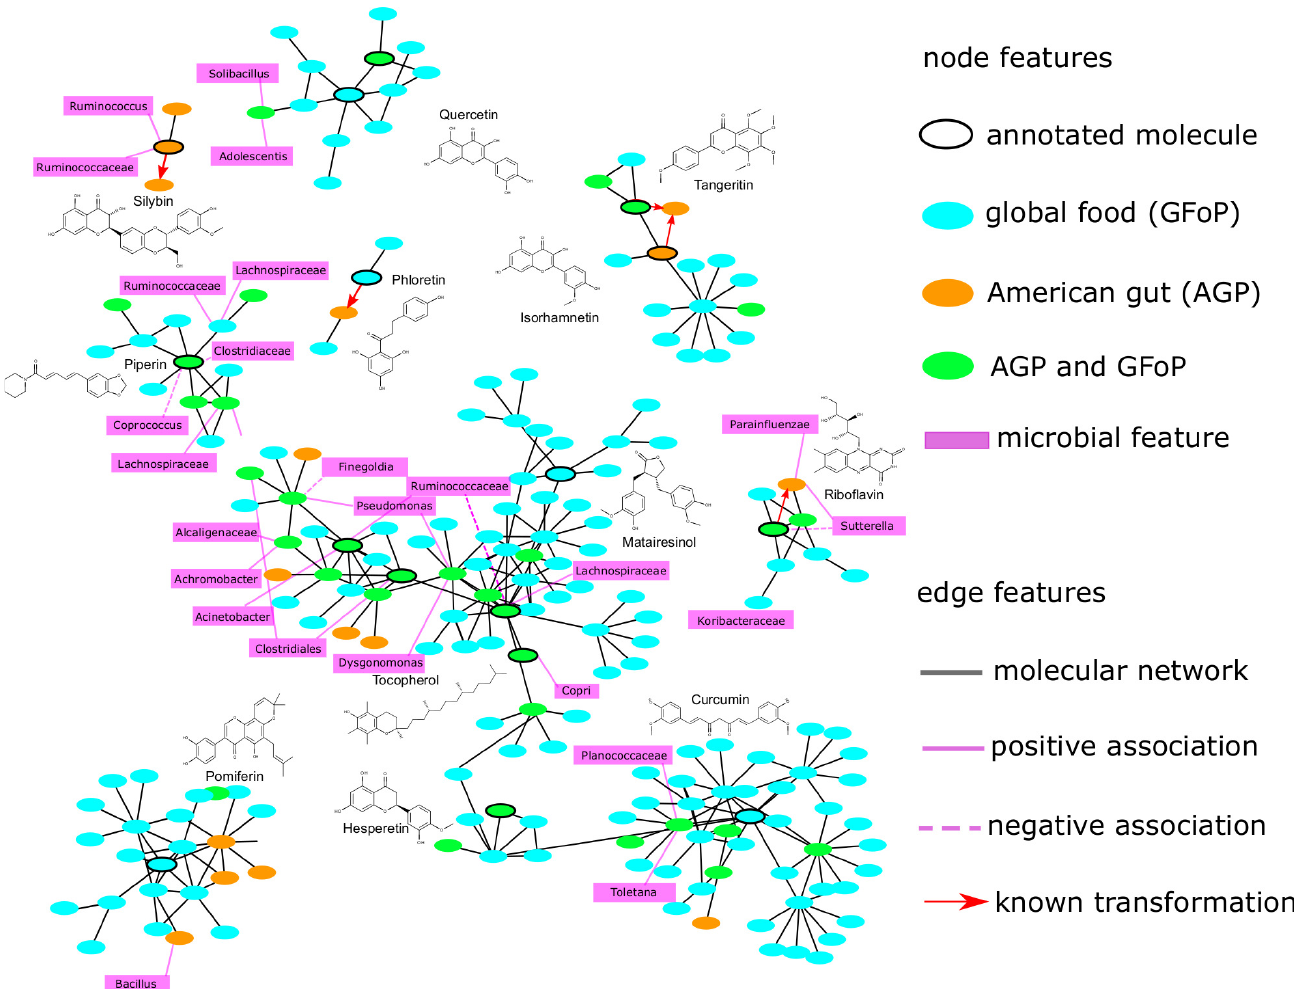
Figure 2. Integrating molecular and association networks. As the size of the network is enormous (41,765 nodes and 45,479 edges), here, we focus on some of the networking families that have a known molecule identified by Dereplicator+ [34] as a polyphenol or a vitamin (25 molecules in total). The network for all 25 molecules is shown in Figure S5. As the association network is currently too dense to visualize, we only show the top two microbial features for each molecular feature (Fisher p - value of 10 − 5 ). The known transformations were reported by BioTransformer [29]. By focusing solely on edges in the molecular network and association network, one can get a large number of potential biotransformations with a high chance of being spurious. However, focusing on the overlap between the two networks (golden triangles) results in a much smaller set of potential biotransformations, where many of them can be validated by a literature